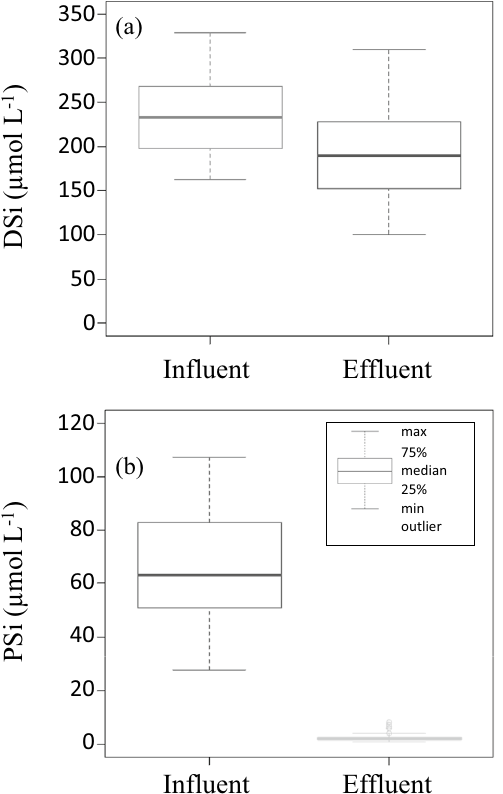
Figure 1. Box plots of annual average ( a ) DSi and ( b ) PSi concentrations (µmol L -1 ) in STP influent and effluent. For each box plot, the median is represented by the bolded line while the 25th and 75th percentile are represented by the bottom and top of the box, respectively. The whiskers represent the minimum and maximum values (1.5 × interquartile range), while outliers are plotted as